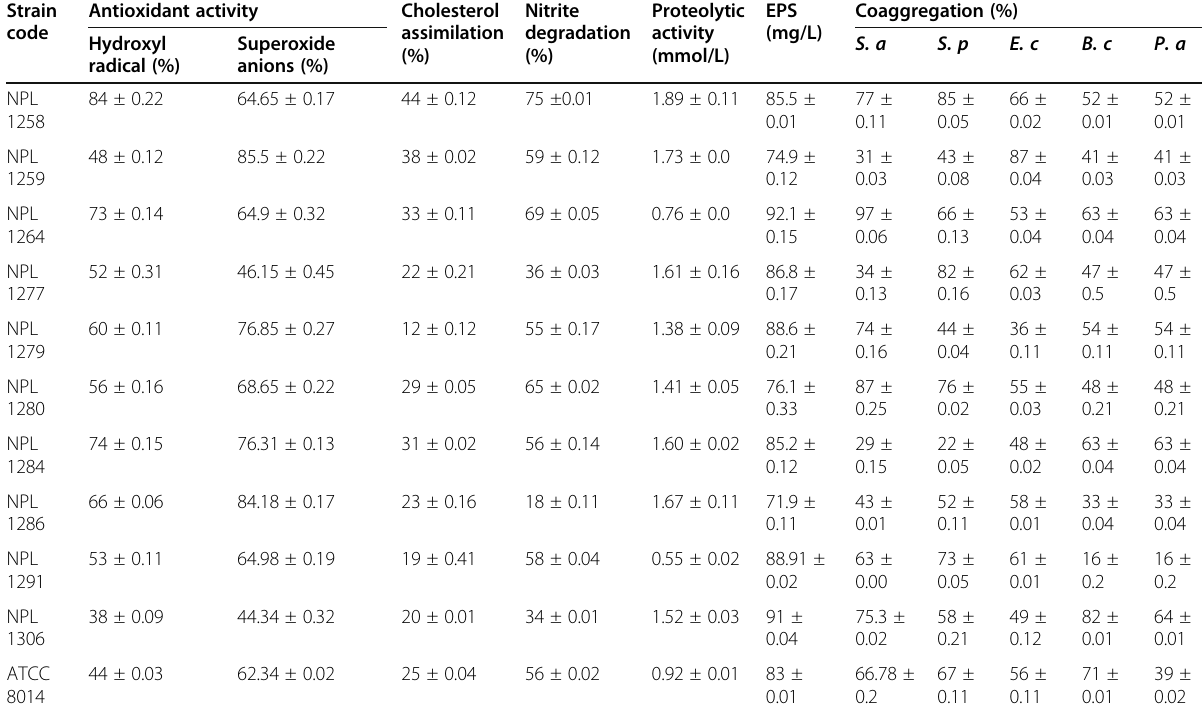
Table 5 Functional properties of selected LAB